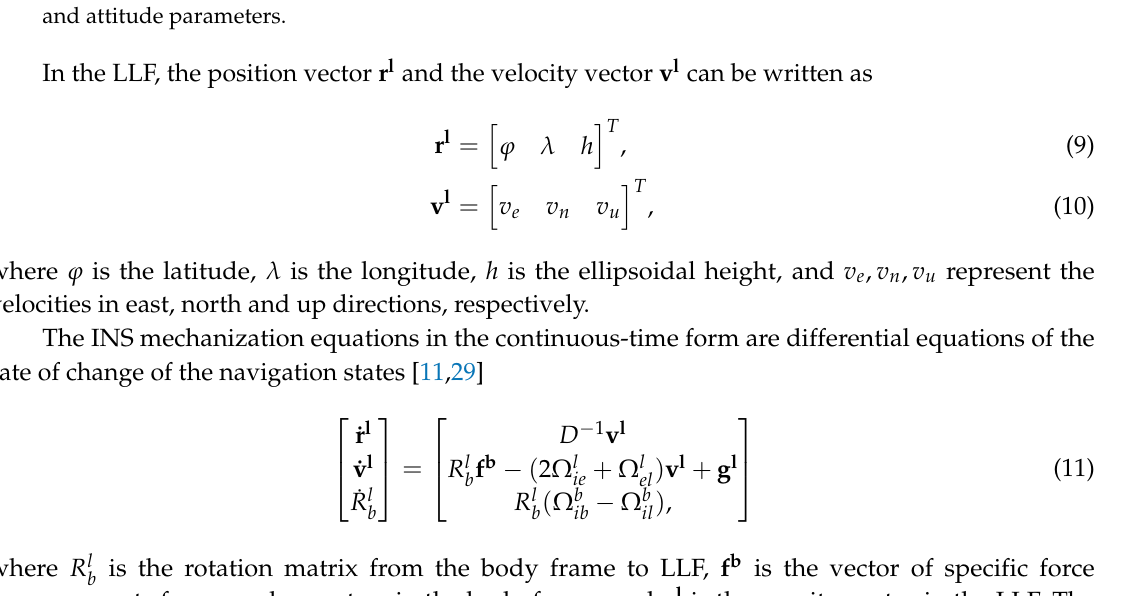
Figure 2. A block diagram of the INS mechanization process [11]. The inputs to the mechanization process are the accelerations and rotations measured by the inertial measurement unit. These measurements are transformed to the navigation frame and integrated to obtain the position, velocity, and attitude